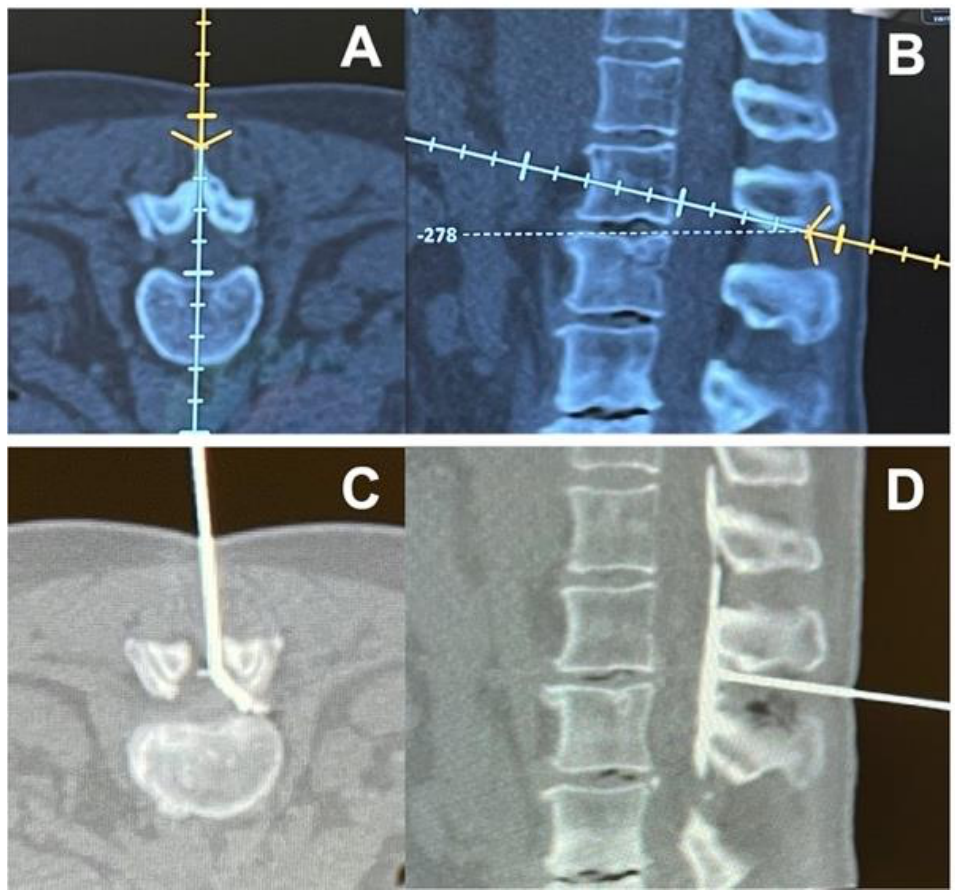
Figure 2. Representative images of ( A , B ) navigated planning of needle path to the epidural space and ( C , D ) evidence of injection in the epidural space by the use of a contrast agent.